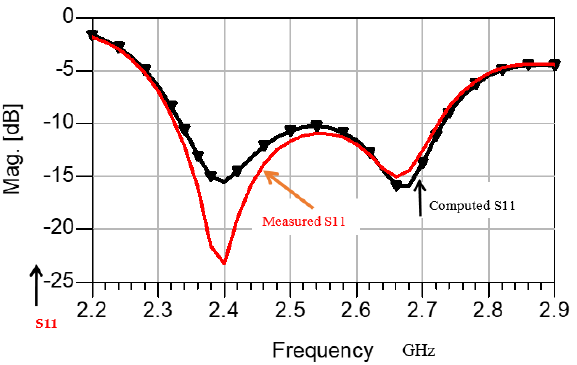
Figure 26. Simulated and measured S11 of the wearable circular Polarized Antenna with CSRR.